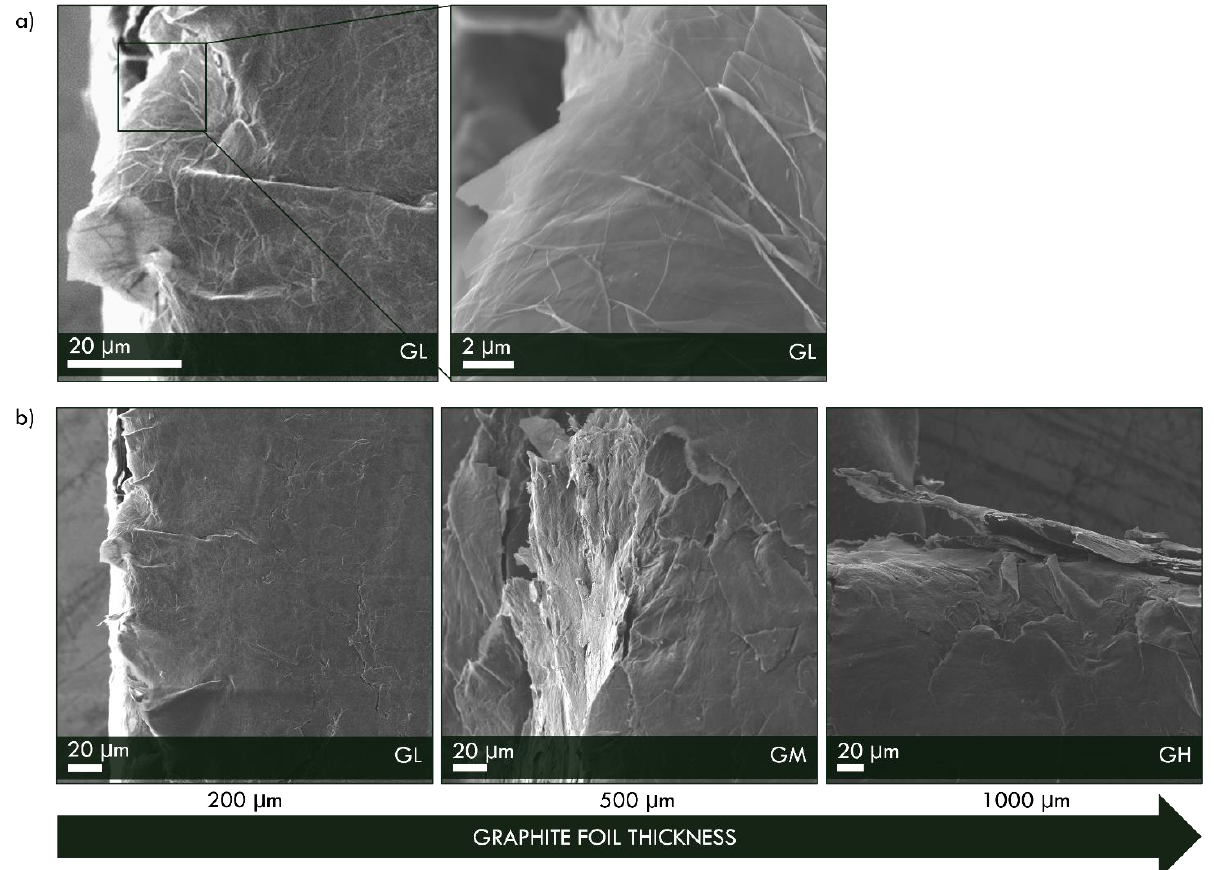
Figure 3 . SEM images of ( a ) GL sample at low and high magnificence, ( b ) GL, GM and GH samples.